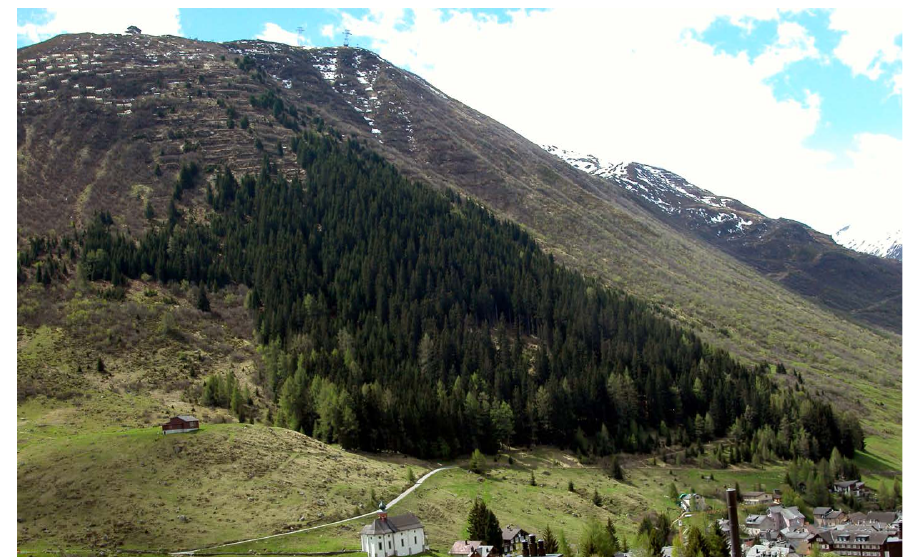
Figure 1: Protection forest of Andermatt (CH) (Photo: P. Brang, WSL) 2 Fig. 1. Protection forest of Andermatt (CH) (photo: P. Brang,